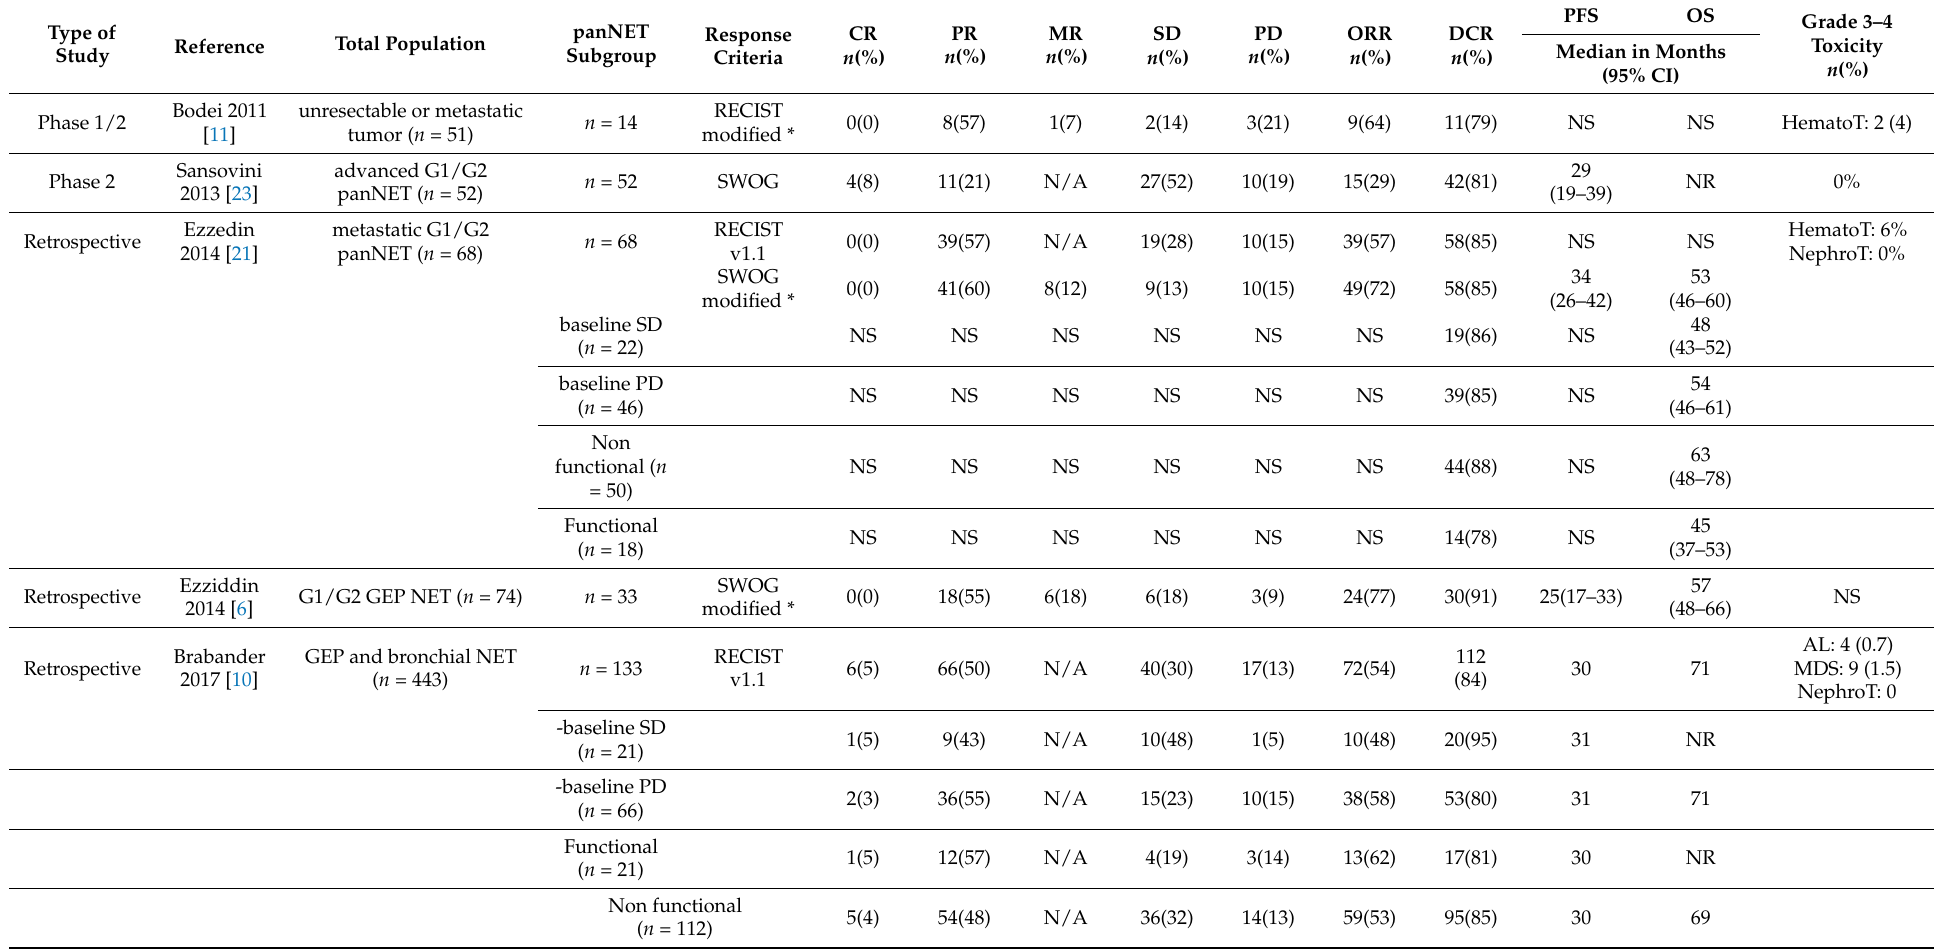
Table 2. Studies reporting 177 Lu-DOTATATE PRRT efficacy and tolerance in pancreatic